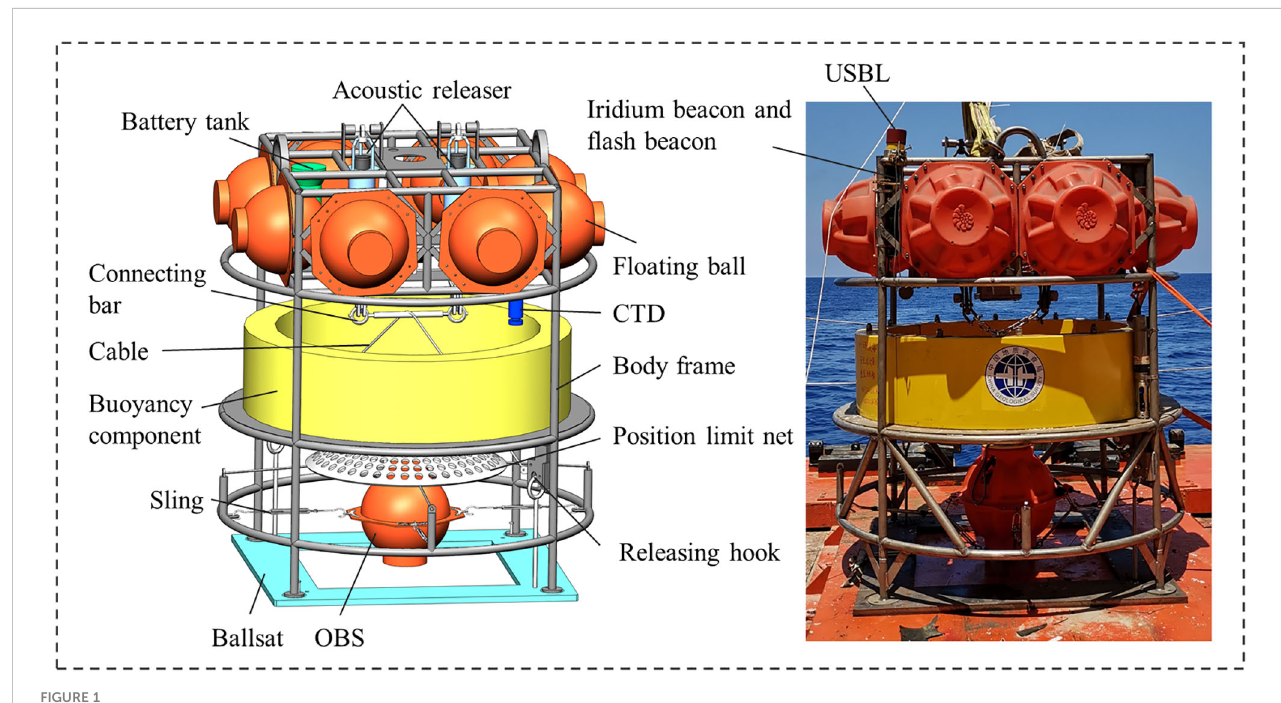
FIGURE 1 The 6000-meter Double Decelerating